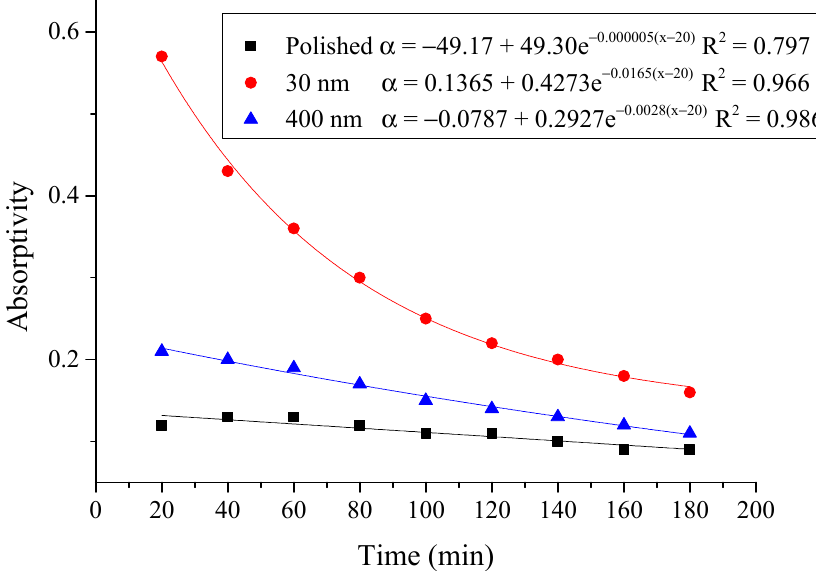
Figure 19. Variation of the average absorptivity for the testing rigs operated under the simulated radiation of 600 W / m 2 .